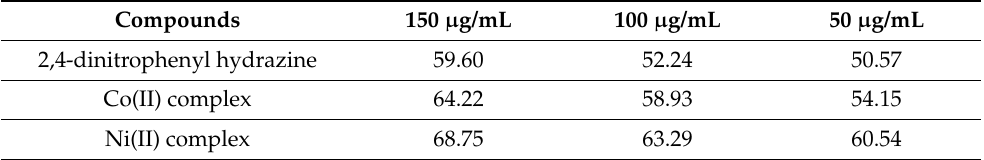
Table 5. Percent of radical scavenging abilities of the Co(II) and Ni(II) complexes and